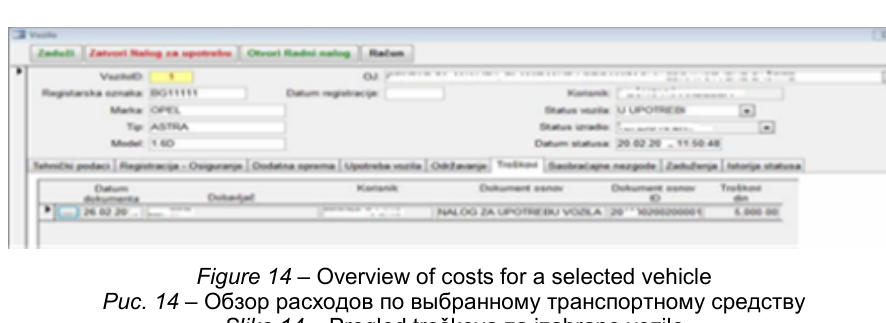
Figure 14 – Overview of costs for a selected vehicle Рис . 14 – Обзор расходов по выбранному транспортному средству Slika 14 – Pregled troškova za izabrano vozilo